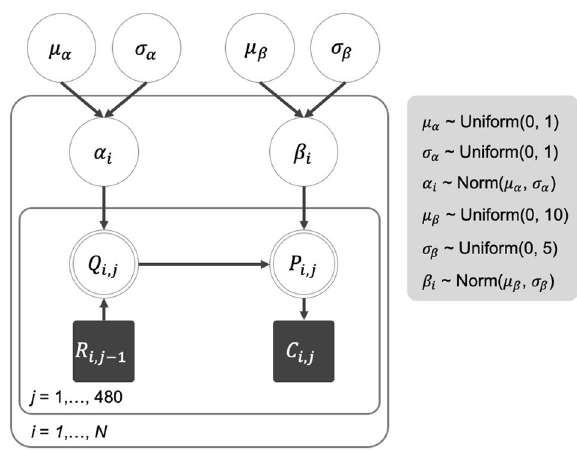
Fig. 4 Graphic display of the Bayesian hierarchical framework for parameter estimation. Following the approach described in Lee and Wagenmakers 70 , the shaded squares, double-bordered circles, and single-bordered circles represent the observed discrete variables, deterministic continuous variables, and latent continuous variables, respectively. The arrows indicate dependencies among these variables. Speci fi cally, R i,j – 1 is the reward feedback (i.e., 1 or 0) received by part i cipant i in trial j − 1, and C i,j is the choice (i.e., A or